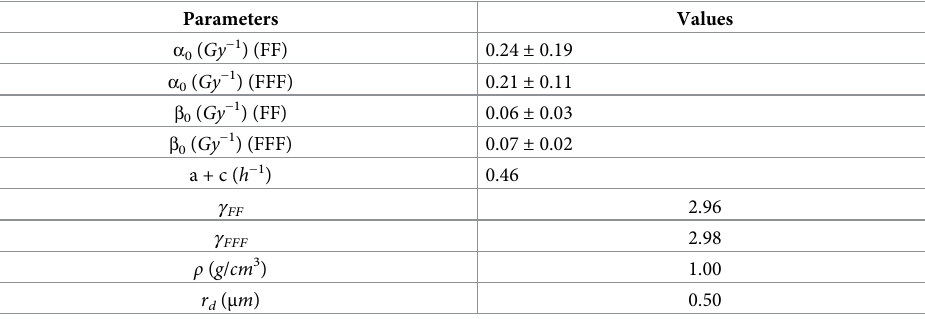
Table 1. MKM simulation parameters obtained using NCI-H460